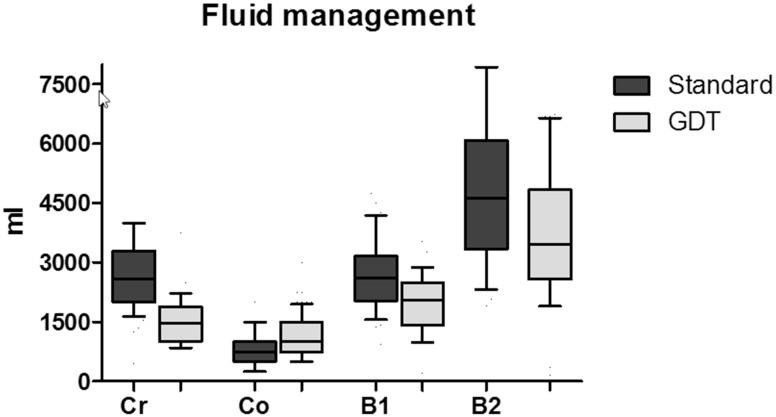
Box and whisker plot of fluid balances and type of fluids used in the GDT and the standard group.The use of crystalloids (Cr), colloids (Co), intra-operative (B1) fluid balance and cumulative balance at dismissal to the ward (B2) are shown. GDT; goal-directed fluid therapy. Boxes represent interquartiles with whiskers showing 10–90% ranges.